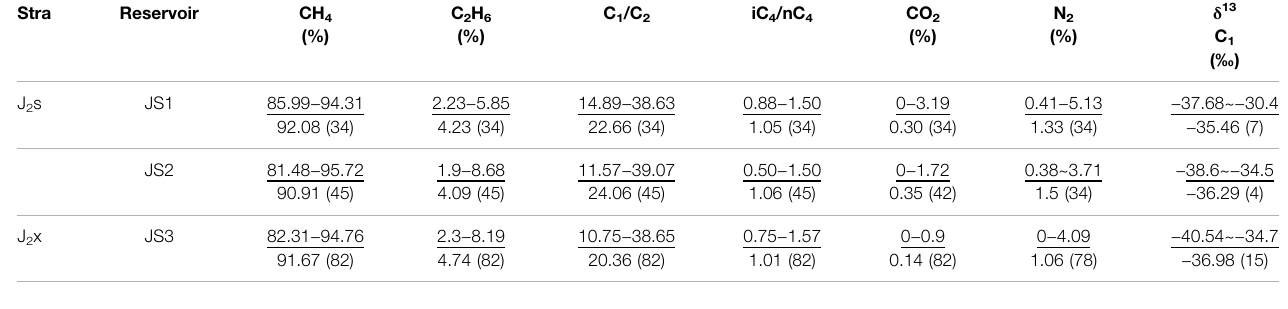
TABLE 1 | Natural gas composition and the carbon isotopic composition of methane in the Middle Jurassic Shaximiao Formation in the Zhongjiang gas fi eld. Stra Reservoir